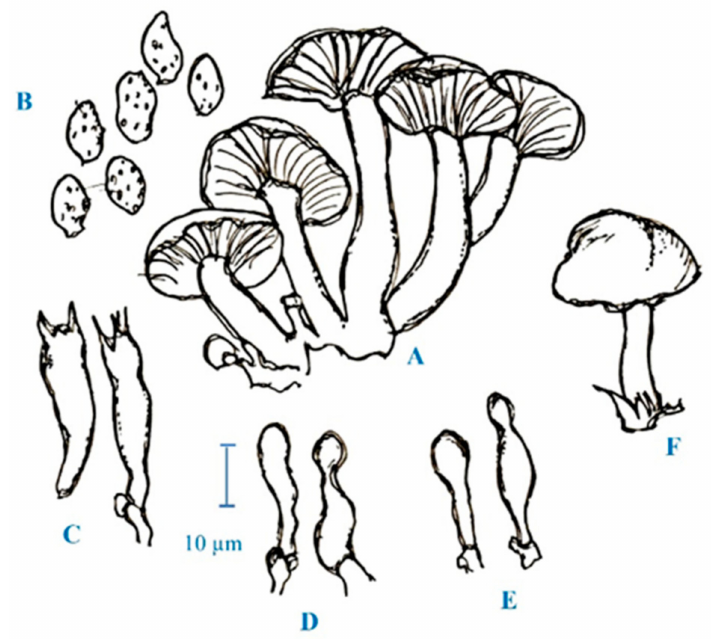
Figure 4. Gymnopilus spectabilis. ( A , F ) Carpophore; ( B ) spores; ( C ) basidia; ( D ) pleurocystidia; ( E )